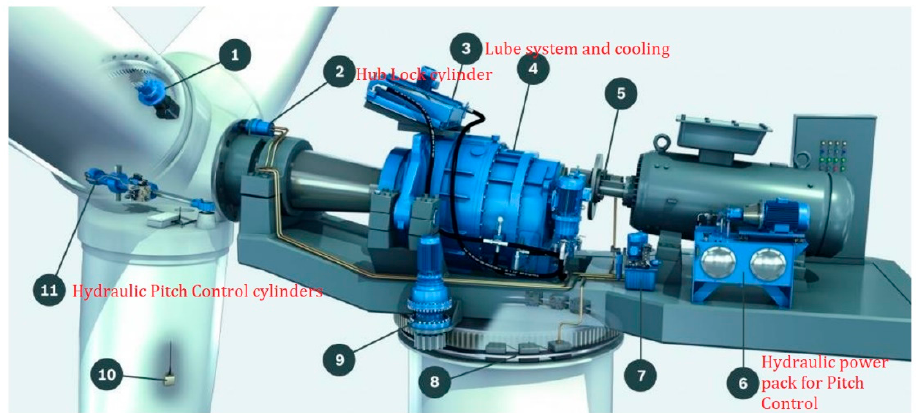
Figure 4. Wind turbine hydraulics [32]; 1—Electromagnetic (rotary) pitch control; 2—hub lock cylinder; 3—lube system and cooling; 4—gearbox; 5—high-speed output shaft; 6—hydraulic power pack for pitch control; 7—brake power back; 8—yaw brake; 9—yaw drive; 10—blade control; 11—hydraulic pitch control cylinders.